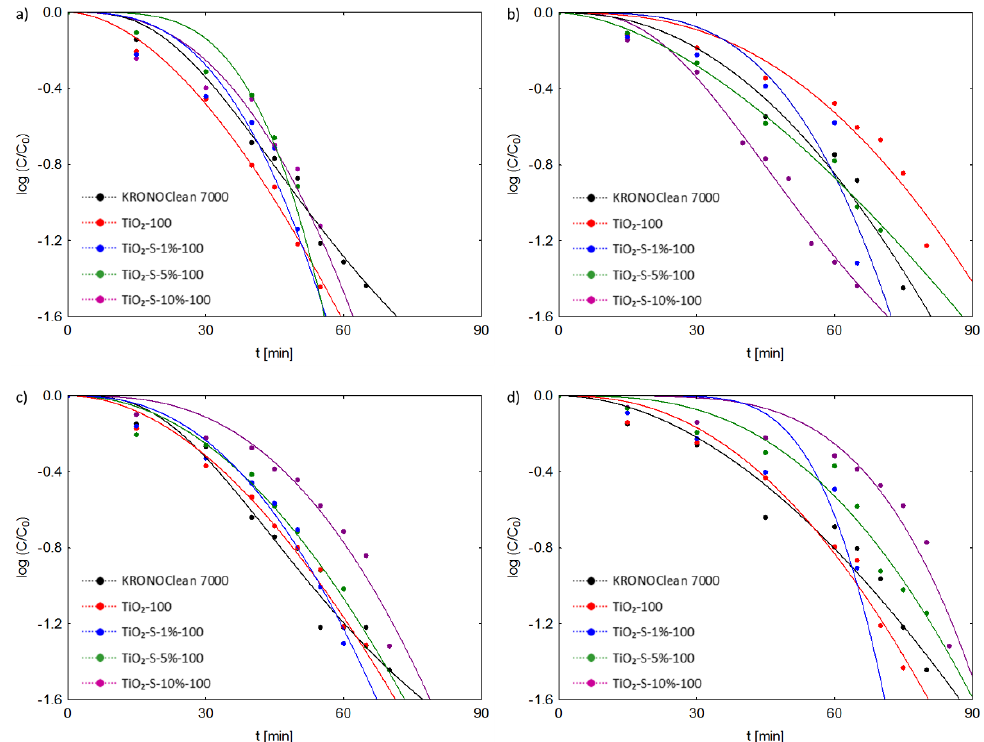
Figure 14. Fitting of Hom kinetic model to experimental data from the photocatalytic process conducted under UV-A or ASL irradiation: ( a ) E. coli (UV-A); ( b ) E. coli (ASL); ( c ) S. epidermidis (UV-A); ( d ) S. epidermidis (ASL).